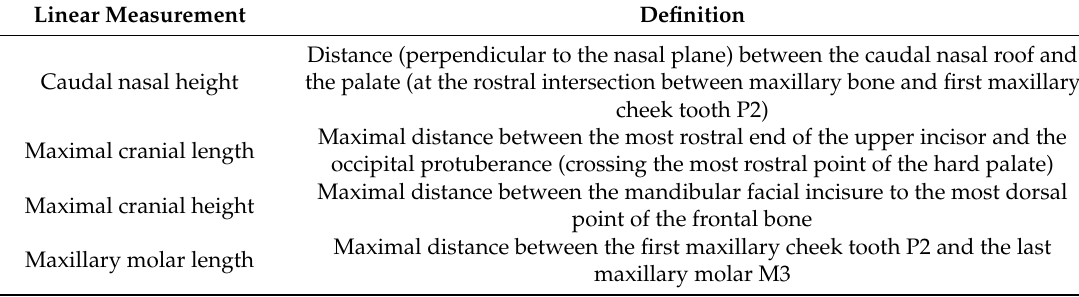
Figure 2. Morphometrics. ( A ) Linear measurements (white) and angles used in the linear morphometric analysis. Planes are indicated with colored lines. Refer also to Table 1. ( B ) Set of 2D landmarks (red) and semilandmarks (green) used in the geometric morphometric analysis. Refer also to Table 2. Table 1. Definition of the established measurements and planes used in the linear morphometric analysis. The linear measurements and the angles were obtained on laterolateral X-ray images of the skull. Refer also to Figure